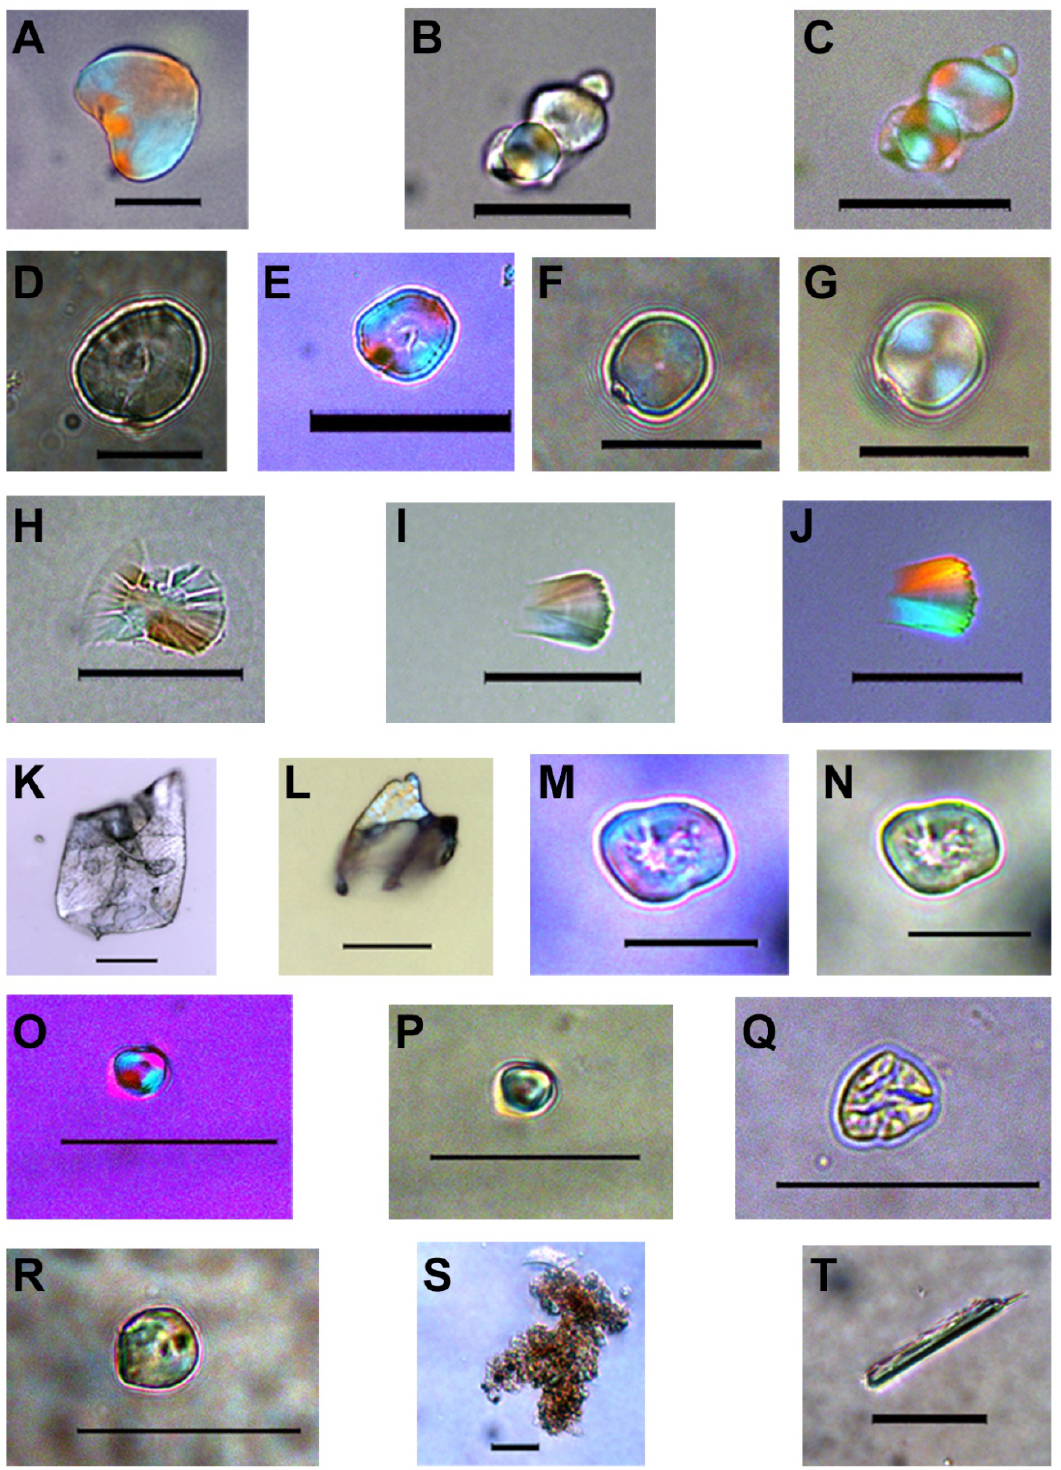
Figure 11. Starch grains and various elements recovered from the sediment I (A-L) and sediment II (M-T) at the right side of the artifact. A-G, M-S: Starch grains. A: Starch grain 1 from sediment I; Starch grains 2-6 from sediment I; D-E: Grain 7 for sediment I; F-G: Grain 8 from sediment I; M-N: Starch 1 from sediment II; O-P: Starch grain 2 from sediment II; Q: Starch grain 3 from sediment II; R: Starch grain 4 from sediment II; S: Starch grains 5-200 from sediment II (35 of them counted and measured for this article). H-J: Non-identified elements; H: Non-identified element 1 from sediment I; I-J: Non-identified element 2 for sediment I. K-L: Vessel elements; K: Vessel element 1 for sediment I; L: Vessel element 2 for sediment 1. T: Possible trichome. Photos taken under bright field (B, D, F, H, I, K, L. N, P, Q, R, S, T) and polarized (A, C, E, G, J, M, O) light. Scale Bar: A-J, M-N, S: 20 µm; O-R, T: 50 µm; K-L: 100 µm. Photos by Rodrigo Angeles